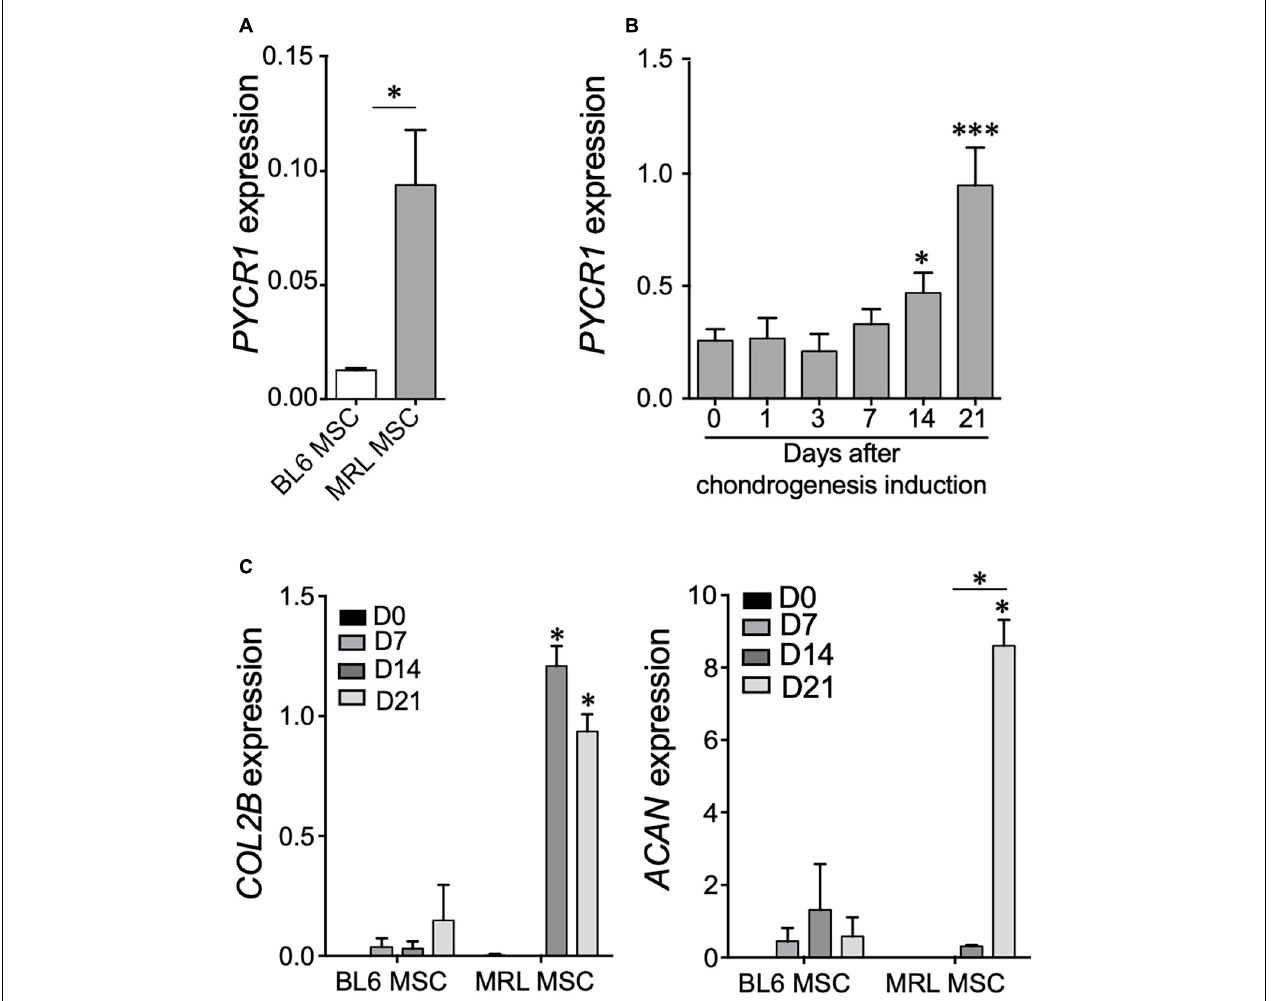
FIGURE 1 | Pycr1 is highly expressed in MRL MSCs and in MSC-derived chondrocytes. (A) Pycr1 mRNA expression level in MRL MSCs and BL6 MSCs assessed by RT-qPCR. (B) Pycr1 mRNA expression level in MRL MSCs at different time points of the chondrogenic differentiation of MRL MSCs induced in pellets by TGF β 3 assessed by RT-qPCR. (C) mRNA expression levels of chondrocyte markers, Col2B and Acan , in BL6 and MRL MSCs at different time points of the chondrogenic differentiation. Results represent the mean ± SEM of three independent experiments. Results represent the mean ± SEM of three independent experiments. Statistics: Mann–Whitney test, two-tailed. When not indicated day 0 (0) versus day 14 (14) or 21 (21), p -values < 0.05 ( ∗ ) or p < 0.001 ( ∗∗∗ ). MRL, Murphy Roths Large; MSCs, mesenchymal stem